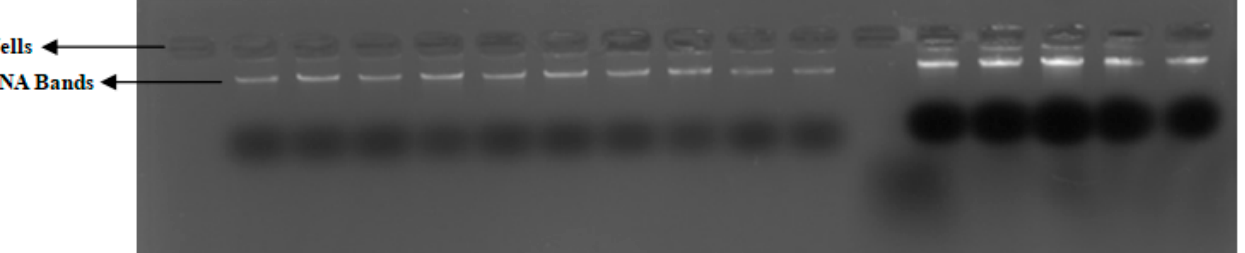
Figure 4. Pattern of DNA (whole DNA extracted from PBMN cells) bands obtained on 2% agarose gel.